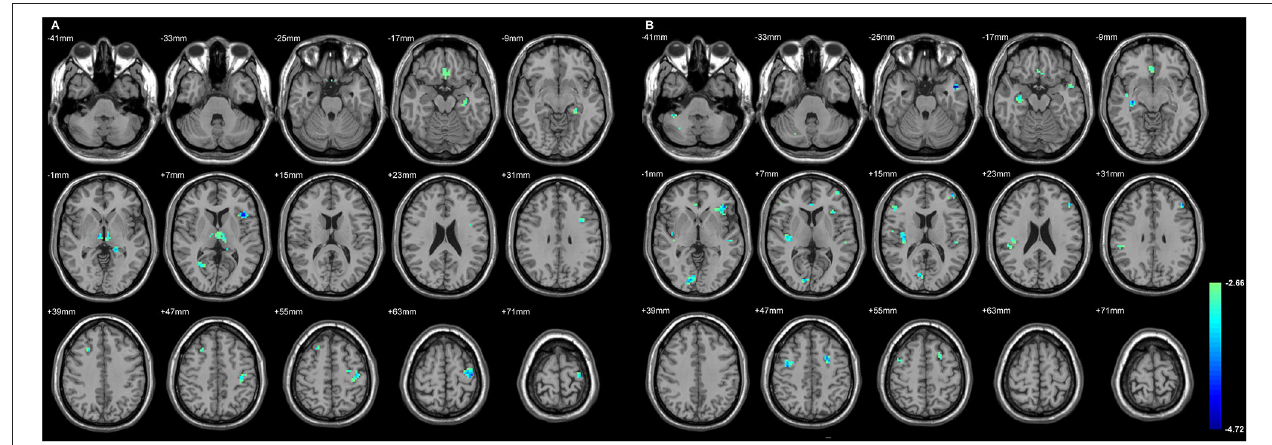
FIGURE 2 | The cortices with significant gray matter density (GMD) changes compared with the normal controls, using age and gender as the covariates (A) in L-TLE, and (B) in right-LTE (R-TLE). All involved regions in both TLE showed decreased GMD, mostly located in the frontal and temporal lobes. Ipsilateral inferior frontal gyrus, precentral gyrus, and medial orbital cortices were affected in both TLE. A T -test comparison was performed between the two groups, using a double statistical threshold (height threshold p < 0.01 and a minimum cluster size = 354 voxels, as determined by the AlphaSim